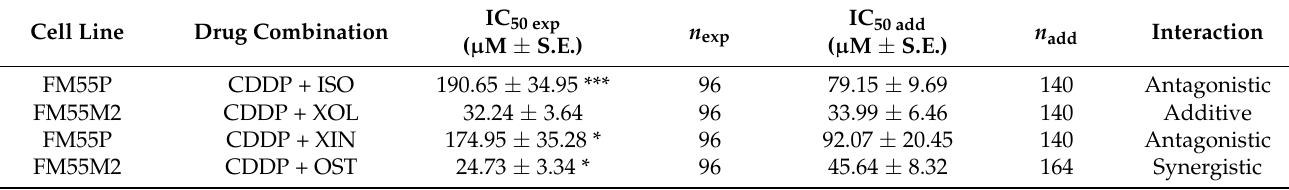
Table 2. Isobolographic analysis of interactions for parallel concentration-response effects in melanoma cell lines. Cell Line